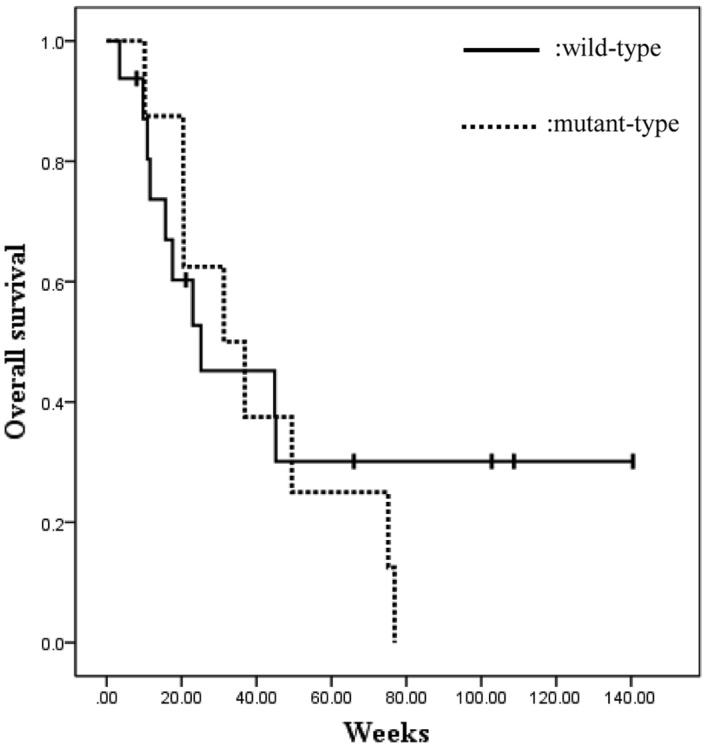
Kaplan-Meier survival plots for OS in advanced CRC treated with cetuximab monotherapy according to the KRAS type. OS, overall survival; CRC, colorectal cancer.